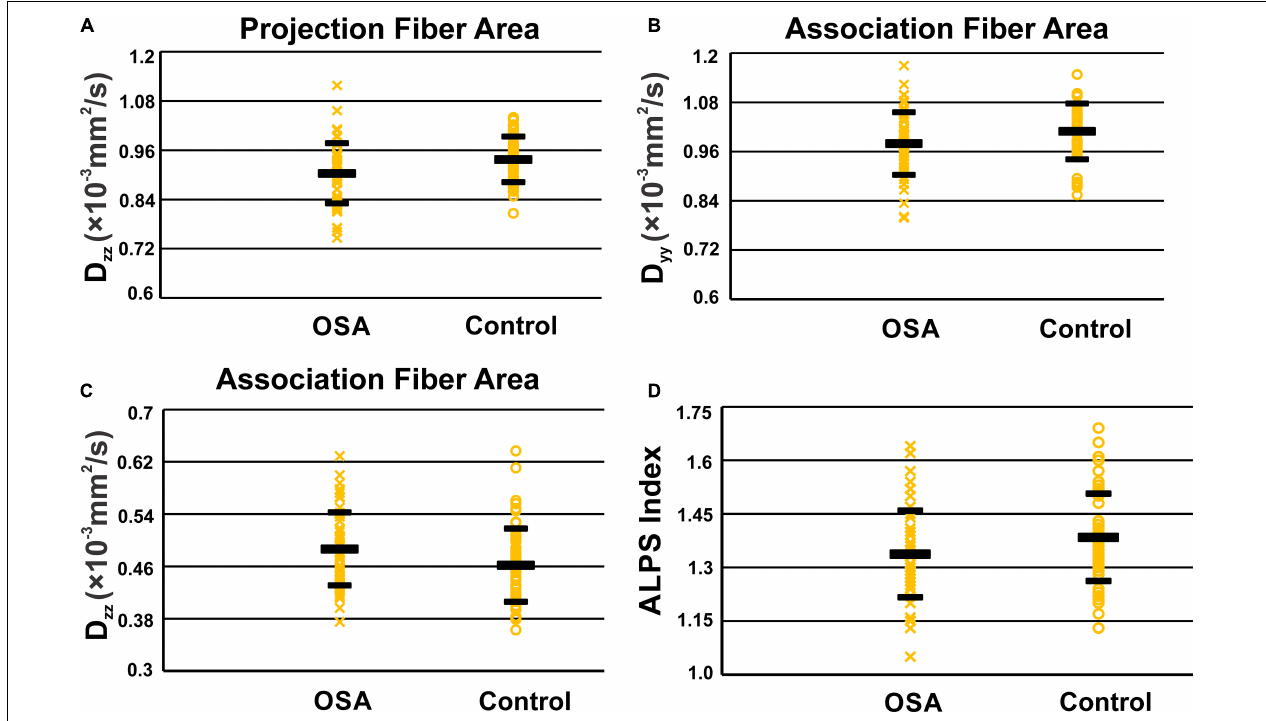
FIGURE 3 | Scatter-plots of D zz in periventricular projection fiber area (A) , D yy (B) , and D zz (C) in association fiber areas and ALPS indexes (D) . Only significant P values were shown in the figures.